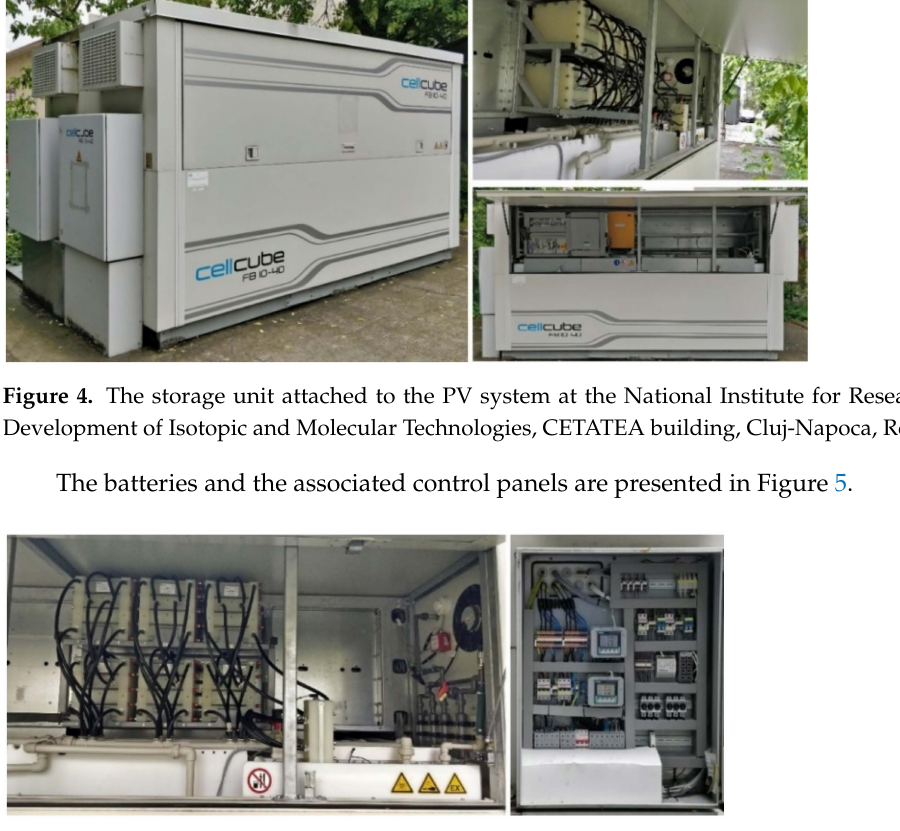
Figure 5. The batteries attached to the PV system including the digital meters of the monitoring panels.